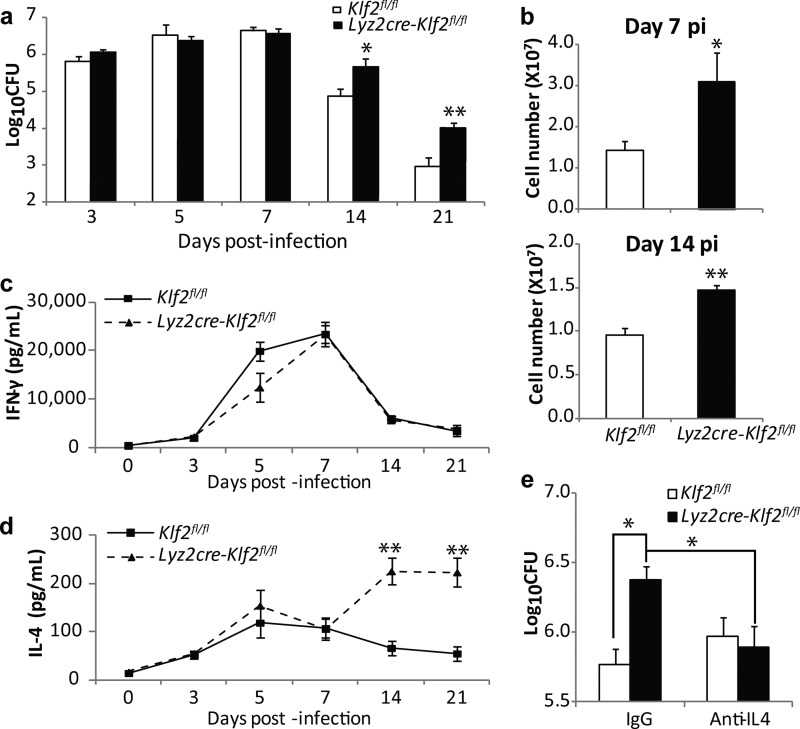
Fungal burdens and immune responses in H. capsulatum-infected mice. (a) Lung fungal burdens at days 3 to 21 p.i. in Lyz2cre-Klf2fl/fl and control mice (n = 4 to 8). (b) Lung leukocytes at days 7 and 14 p.i. (n = 5 to 8). (c and d) IFN-γ (c) and IL-4 (d) concentrations in lung homogenates (n = 5 to 11, except n = 3 at day 5 p.i.). *, P < 0.05, and **, P < 0.01, for comparison with the results for control mice by t test. (e) Fungal burdens at day 14 p.i. in the lungs of mice treated with IgG or anti-IL-4 Ab (1 mg/mouse) (n = 6). *, P < 0.05, and **, P < 0.01, by two-way ANOVA. Data represent the mean results ± standard errors of the means (SEM).